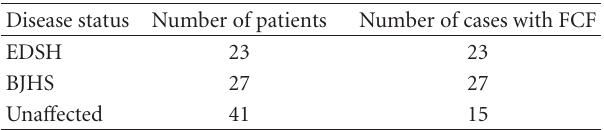
Table 1: Frequency of finding flower-like collagen fibrils (FCF) in patients with Ehlers-Danlos syndrome hypermobile (EDSH) and in patients with the benign joint hypermobility syndrome (BJHS).